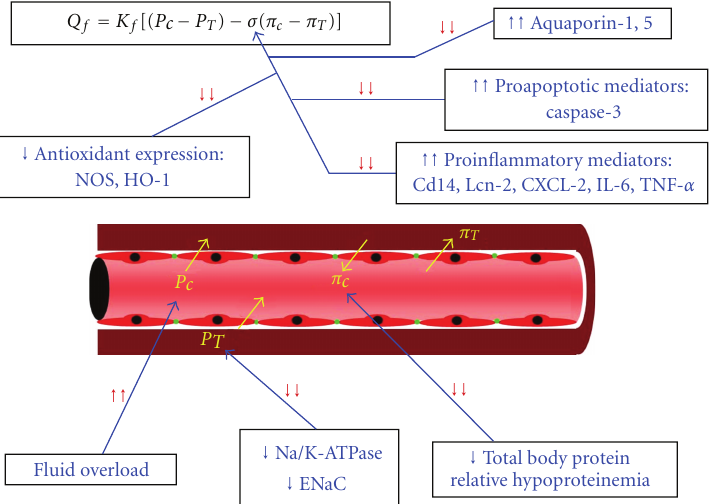
Figure 1: Nephrogenic pulmonary edema. Acute kidney injury triggers numerous mechanisms which alter the homeostasis of pulmonary interstitial and alveolar fluid balance. Q f : net flow across the alveolar-capillary membrane; K f : filtration coe ffi cient; P C : capillary hydrostatic pressure; P T : interstitial fluid hydrostatic pressure; σ : reflection coe ffi cient of the alveolar-capillary membrane; π C : capillary oncotic pressure; π T : interstitial oncotic pressure; NOS: nitric oxide synthase; HO-1: heme-oxygenase-1; Lcn-2: lipocalin-2; CXCL-2: chemokine ligand-2; IL-6: interleukin-6; TNF- α : tumor necrosis factor- α ; Na/K-ATPase: sodium-potassium ATPase; ENaC: endothelial sodium channel. It is important to note that negative changes in the reflection coe ffi cient likely also increase the filtration coe ffi cient leading to a net increase in fluid flow across the alveolar-capillary